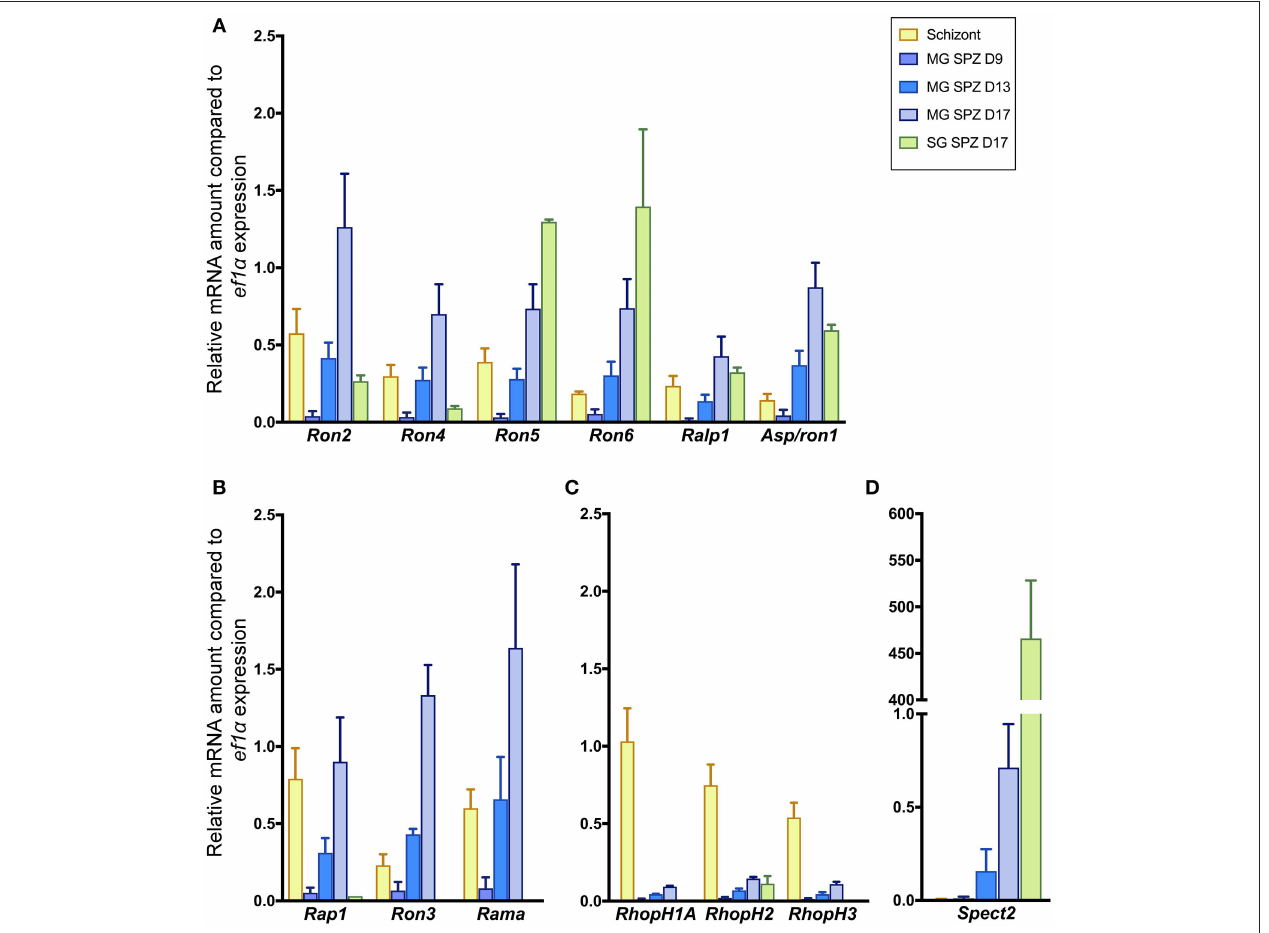
FIGURE 1 | Transcriptional analyses of rhoptry genes in sporozoites and schizonts. Total RNA was extracted from parasite-infected mosquito midguts at days 9, 13, and 17 post-feeding (MG SPZ D9, MG SPZ D13, and MG SPZ D17); and salivary glands at day 17 post-feeding (SG SPZ D17). Total RNA was also extracted from schizont-enriched infected erythrocytes (Schizont). The mean values of relative mRNA amounts of each molecule, normalized by ef1 α mRNA expression, are plotted as bar graphs with standard deviations from three independent experiments. (A) A group of molecules categorized as rhoptry neck proteins in merozoites. All examined molecules are transcribed in both merozoites and sporozoites. (B) A group of molecules categorized as rhoptry bulb proteins in merozoites whose transcriptions are detected in both merozoites and sporozoites. (C) A group of molecules categorized as rhoptry bulb proteins in merozoites whose